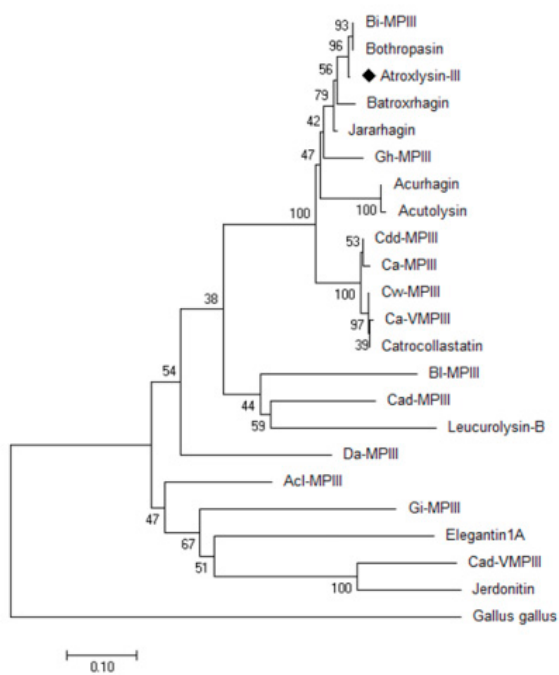
Figure 4. Phylogenetic tree of the P-III SVMPs. The amino acid sequences of 22 SVMPs were used for phylogenetic tree construction by the program Mega 5.1. Atr-III from Peruvian Bothrops atrox is marked ( ♦ ) and the others P-III class SVMPs: Bi ( Bothrops insularis , AF490534); Bothropasin ( Bothrops